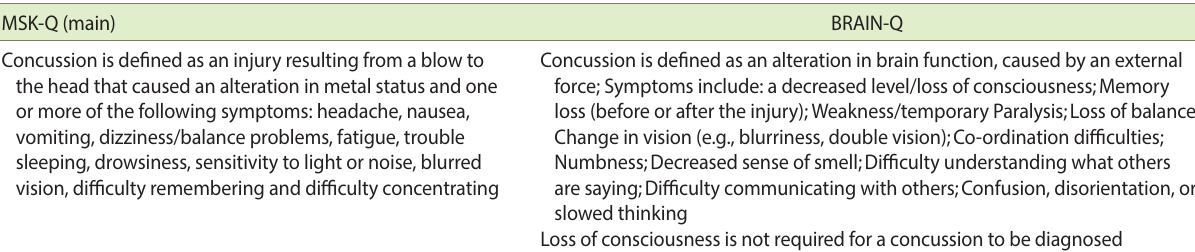
Table 2. Concussion definitions provided by each assessment tool MSK-Q (main)